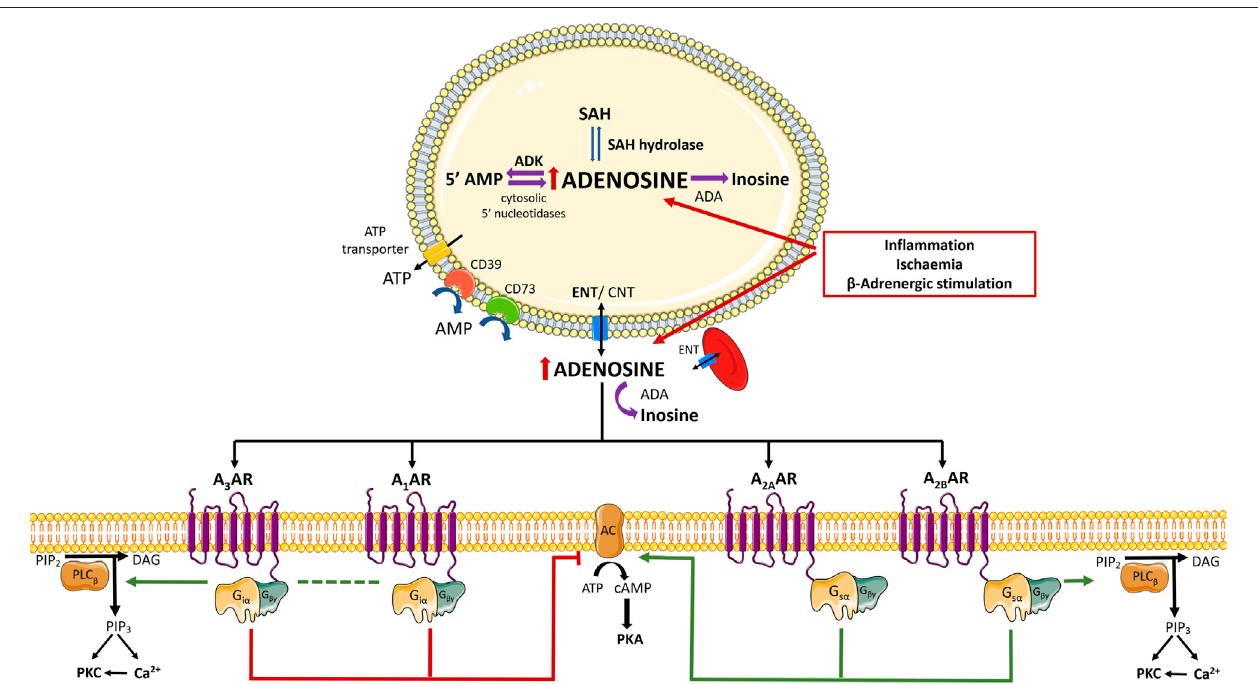
FIGURE 1 | Schematic representation of adenosine biosynthesis and complex signalling pathways induced by adenosine receptors activation. Adenosine is a purine nucleoside continuously generated from the catabolism of adenine nucleotides via a cascade of nucleotidases. Regarding the fate of intracellular adenosine, it may (preferentially) re-enter the purines savage pathway by intracellular phosphorylation via adenosine kinase (ADK) or it is inactivated to inosine by adenosine deaminase (ADA). The main source of adenosine results from the hydrolysis of S-adenosylhomocysteine (SAH) by SAH hydrolase. Under low oxygen availability and/or during high energy working loads, recruitment from ATP hydrolysis increases favouring intracellular adenosine accumulation, which promotes its diffusiontotheextracellularmediumviaequilibrativenucleosidetransporters(ENTs).Extracellularadenosinemayalsoresultfromtheextracellularbreakdownofreleased adenine nucleotides, namely adenosine 5 ′ -triphosphate (ATP), ADP (adenosine 5 ′ -diphosphate), and AMP (adenosine 5 ′ -monophosphate), by a cascade of ecto- nucleotidases bound to the plasma membrane. CD39 dephosphorylates ATP directly into AMP; the rate limiting enzyme of the ecto-nucleotidase cascade is ecto-5 ′ - nucleotidase/CD73,whichdephosphorylatesAMPtoadenosineandinorganicphosphate.ExtracellularadenosinelevelsaretightlyregulatedbycellularuptakeviaENTs and/or by deamination into inosine by ADA. Adenosine activates 4 G protein-coupled receptor (GPCRs) known as P1 receptors (adenosine receptors (ARs): A 1 AR, A 2A AR,A 2B AR,A 3 AR).Inbrief,A 1 ARandA 3 ARarenegativelycoupledtoadenylatecyclase(AC)throughbindingtoG i andG o proteins,resultingindecreasedintracellular cyclic AMP (cAMP) levels. Both A 2A AR and A 2B AR are coupled to G s proteins and stimulate AC leading to increases in cAMP accumulation. Despite the canonical positive and negative coupling to the AC/cAMP system, A 1 AR, A 2B AR, and A 3 AR are also entitled to activate phospholipase C-beta (PLC- β ) isoform, resulting in increased inositol 1,4,5-trisphosphate (IP3) and intracellular Ca 2+ mobilization; intracellular Ca 2+ and diacylglycerol (DAG) production contribute to stimulate Ca 2+ - dependent protein kinase C (PKC) and/or downstream Ca 2+ -dependent pathways. Adapted from (Borea et al., 2018). Green arrows and red bars indicate the effects inducedorblockedbyadenosinereceptoractivation,respectively.IllustrationusedelementsfromServierMedicalArt(http://smart.servier.com).AC,Adenosinecyclase; ADA, Adenosine deaminase; ADP, 5 ′ adenosine diphosphate; ADK, Adenosine kinase; AMP, 5 ′ -adenosine monophosphate; AR, Adenosine receptor; ATP, 5 ′ - adenosine triphosphate; cAMP, cyclic AMP; CNT, Concentrative nucleoside transporter; DAG, diacylglycerol; ENT, Equilibrative nucleoside transporter; GCPR, G protein-coupled receptor; IP3, inositol 1,4,5-trisphosphate; PKA, protein kinase A; PKC, protein kinase C; PLC- ß , Phospholipase C- beta; SAH, S-adenosylhomocysteine.